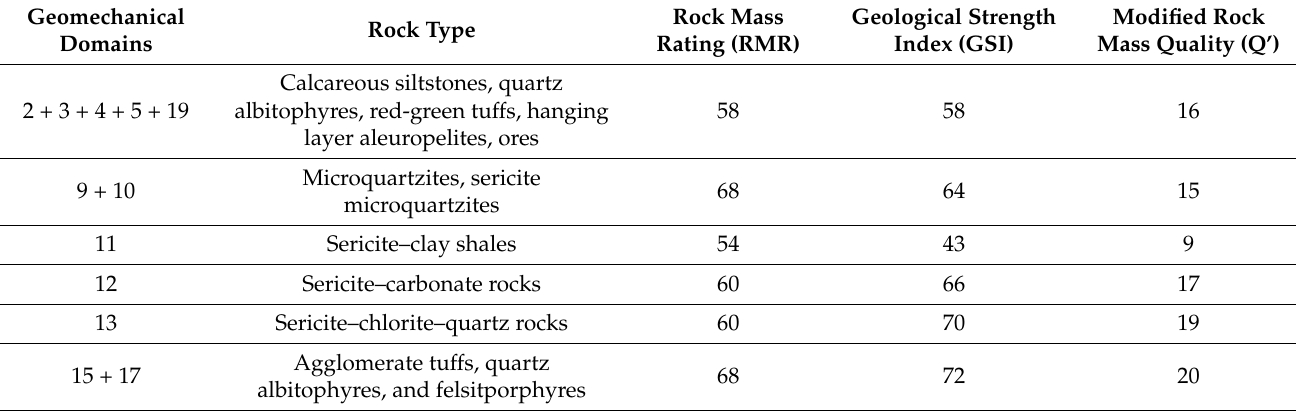
Table 2. Generalized rating indicators of the Ridder–Sokolny array